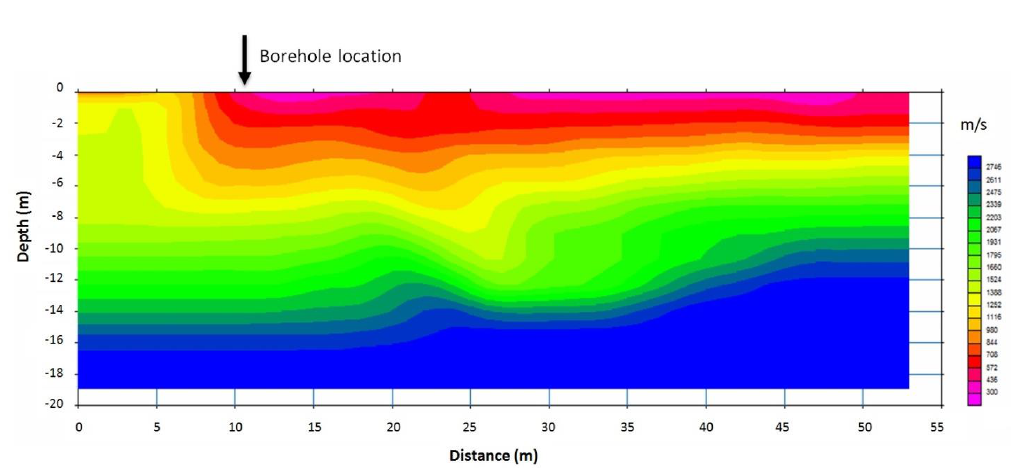
Figure 3. P-wave velocity distribution in the study area from seismic refraction tests.